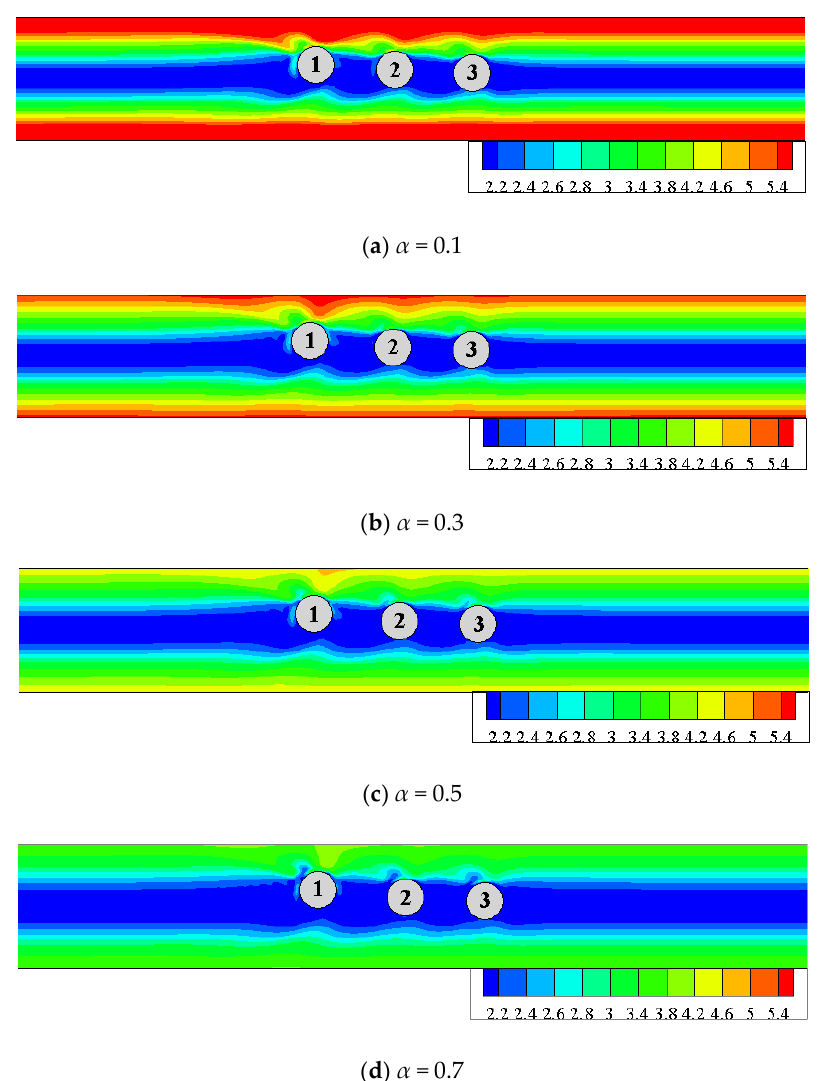
Figure 10. Polymer extension tr( B ) along the pathway in Giesekus fluid at t = 3 ( Wi = 0.5, η r = 0.3, ε = 0.3, y 0 = 0.1, d 1,0 = d 2,0 = 0.3). ( a ) α = 0.1; ( b ) α = 0.3; ( c ) α = 0.5; ( d ) α = 0.7.